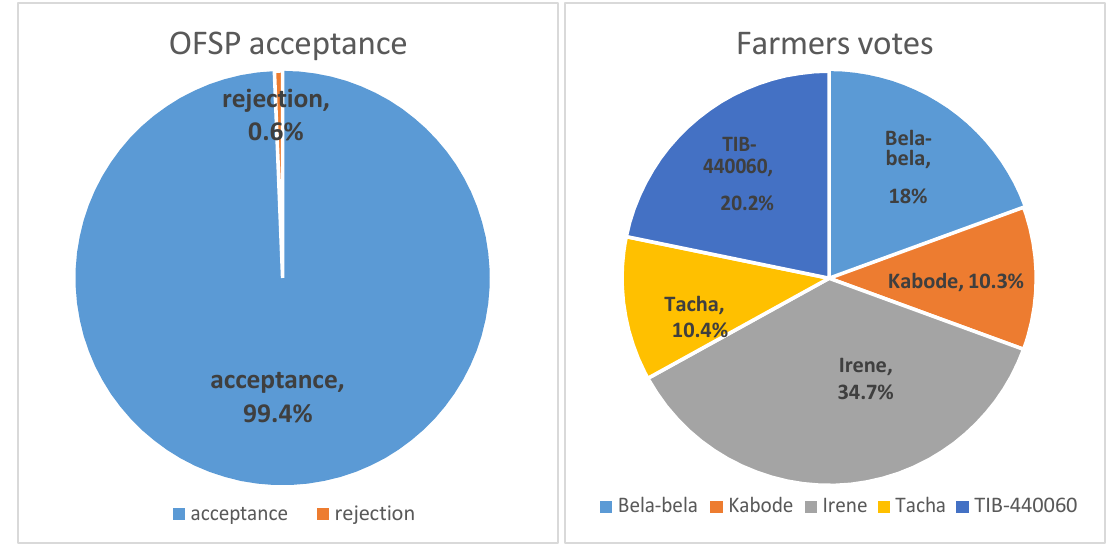
Figure 3: OFSP acceptance and choice of varieties by